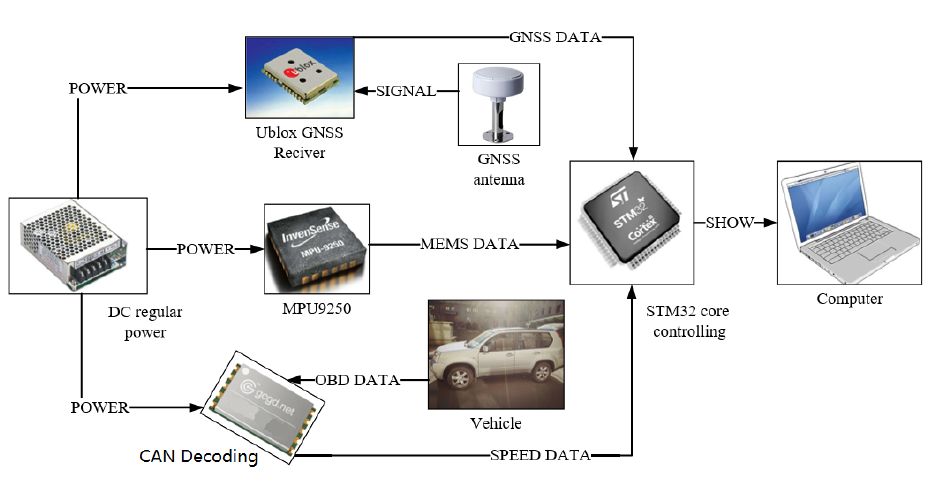
Figure 4. Experimental equipment structure